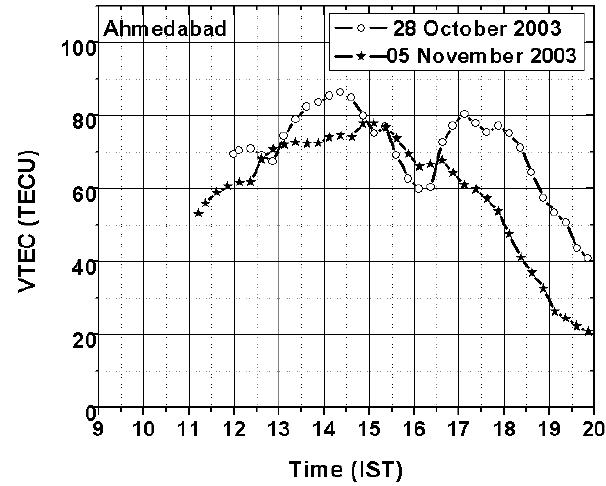
Fig. 4. The temporal variation of VTEC (averaged from satellite passes obtained within 15min slots) for the station Ahmedabad near the EIA crest on 28 October 2003 (solid line) and 5 November 2003 (dashed